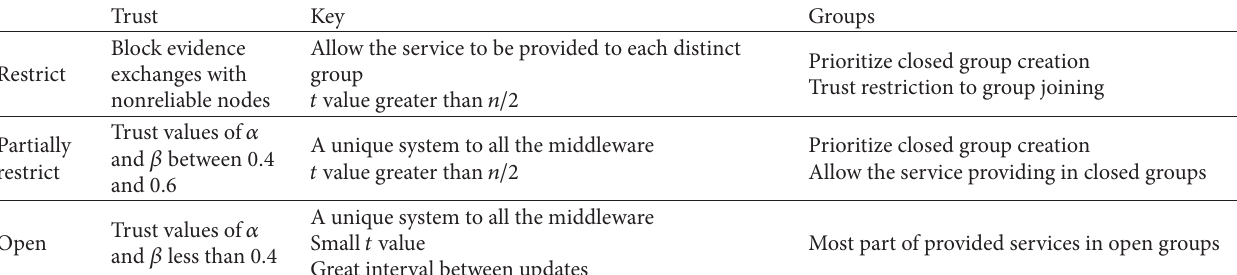
Table 1: Security policies for distinct scenarios.